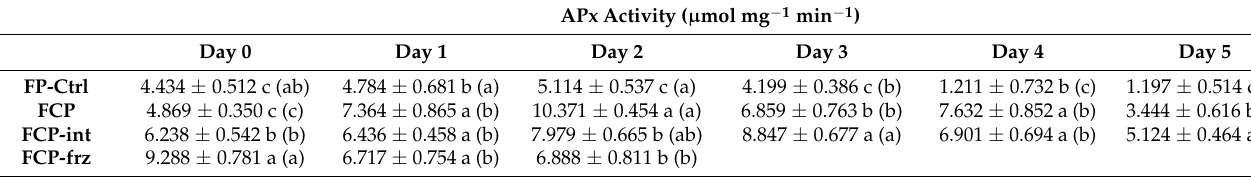
Table 1. Changes in APx activity in fresh and fresh-cut parsley under different storage conditions, assayed from the decrease in absorbance at 290 nm as ascorbate was oxidized and expressed as µ mol of AA converted by APx per milligram of protein per minute at 25 ◦ C. Values are means ± standard deviation, n = 3. Means in columns followed by unlike letters differ significantly by Fisher’s least significant difference (LSD) test, p ≤ 0.05. Means in rows followed by (unlike letters) differ significantly by Fisher’s least significant difference (LSD) test, p ≤